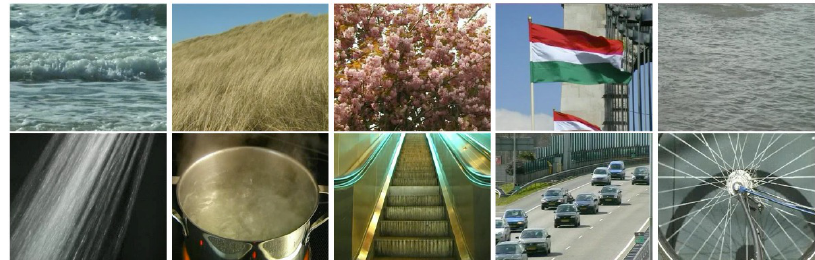
Figure 1. Sample snapshots from different categories of the DynTex